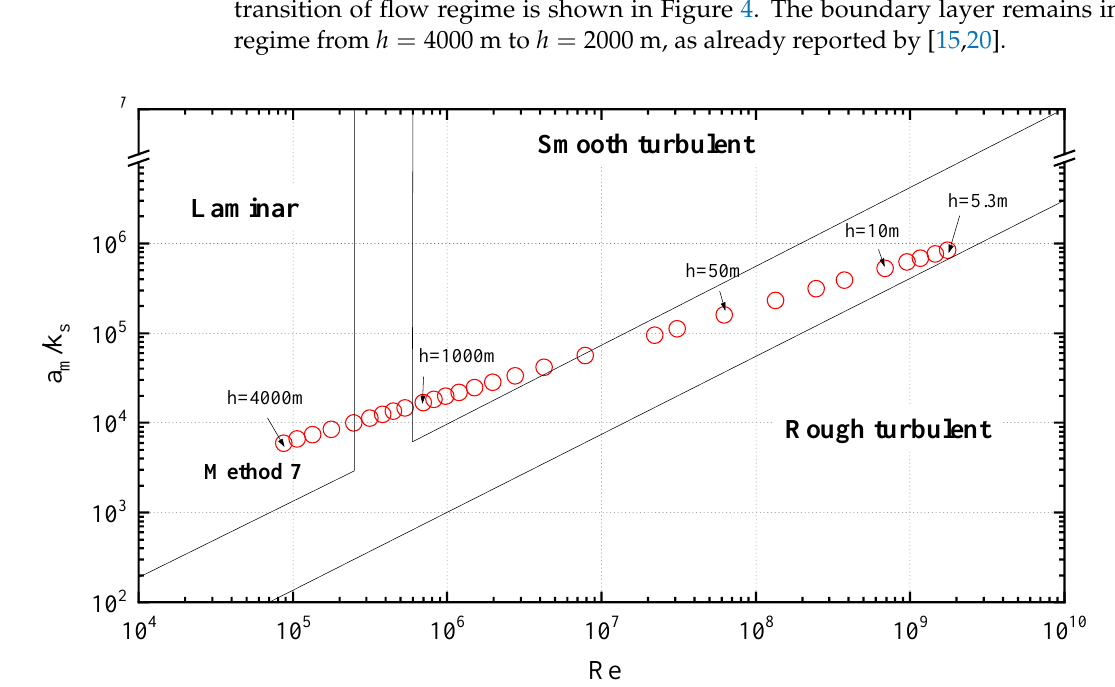
Figure 6. Boundary layer thickness under a shoaling tsunami.